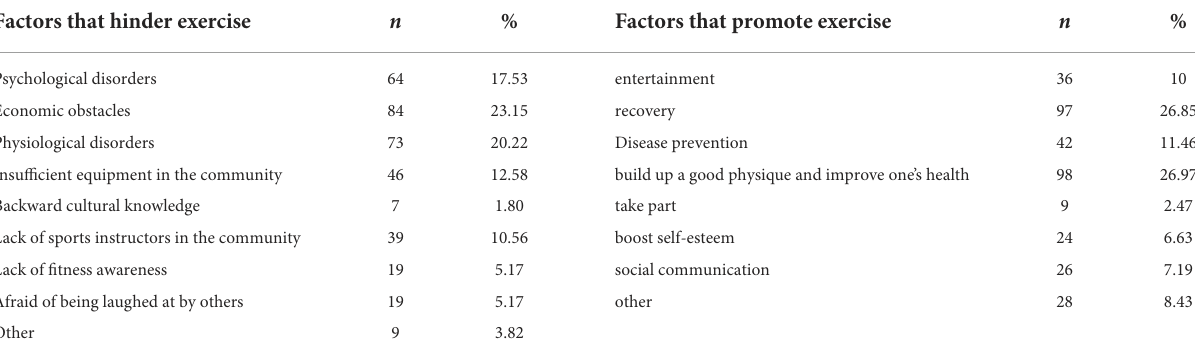
TABLE 3 Factors influencing exercise for people with